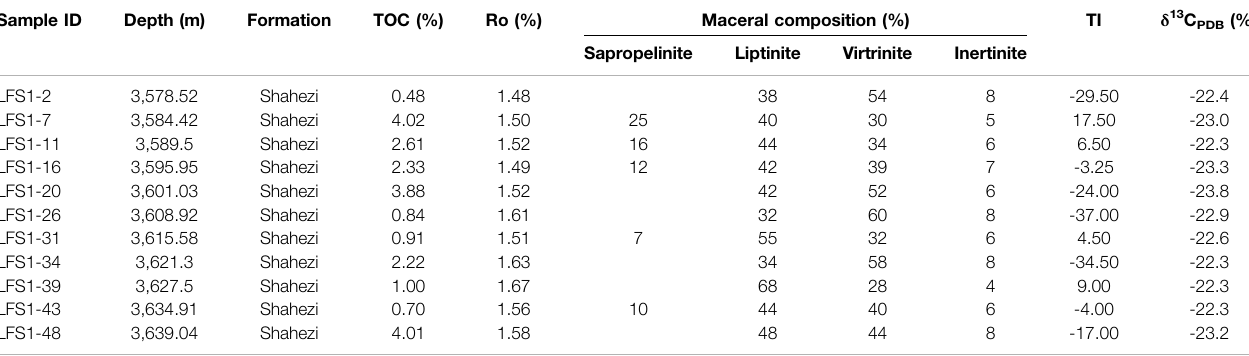
TABLE 2 | Geochemical data on shale samples for the Shahezi Formation. Sample ID Depth (m) Formation